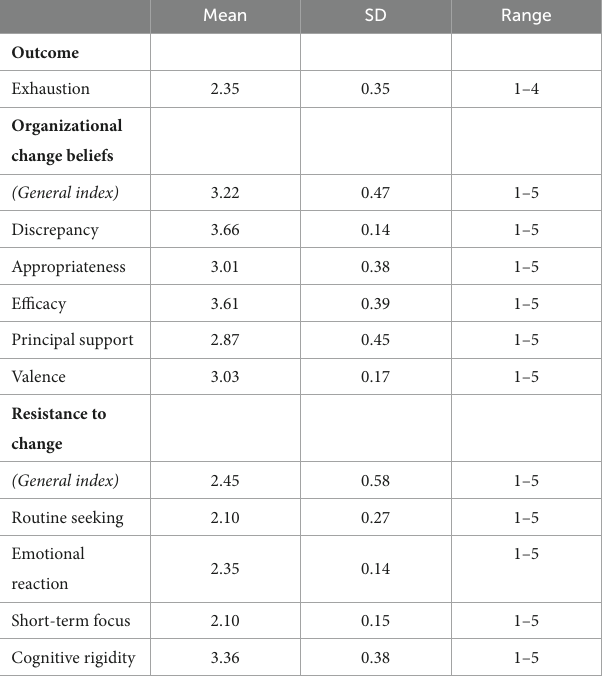
TABLE 2 Means, standard deviations of the scales and observed ranges for each